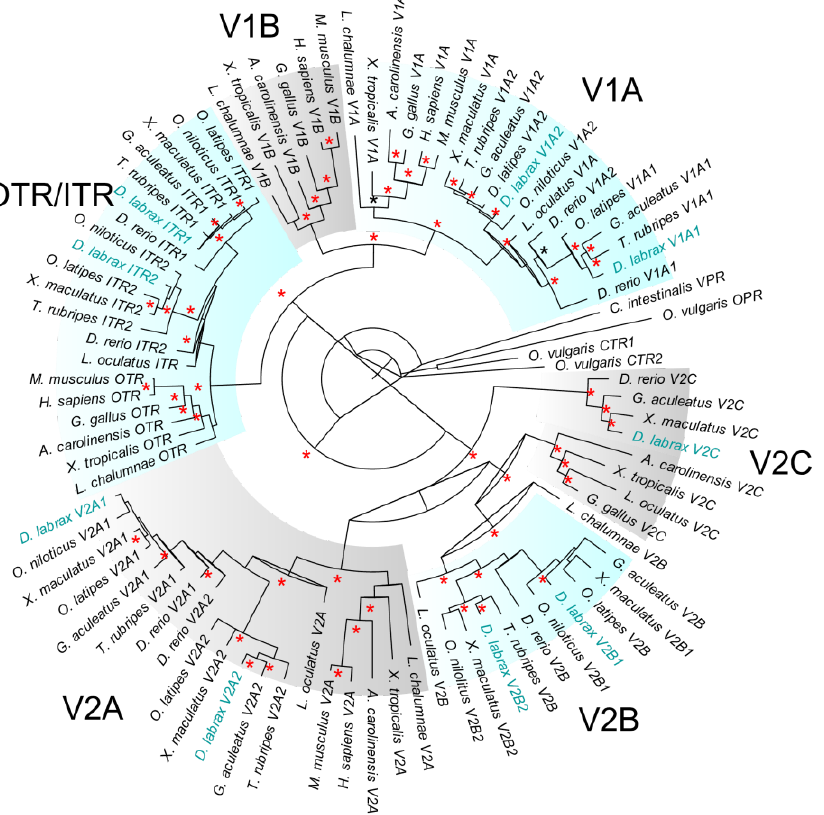
Figure 1. Phylogenetic tree of AVTRV-1A1, -1A2, -2A1, -2A2, -2B1, -2B2, -2C, ITR1 and ITR2. Sequences from European sea bass are indicated in blue. Branch lengths represent the degree of divergence. Bayesian posterior probabilities (bpp) are indicated in nodes as red asterisks (if bpp ≥ 0.99) and in black asterisks (if 0.95 ≤ bpp ≥ 0.98). Nodes with bpp < 0.95 are not annotated.